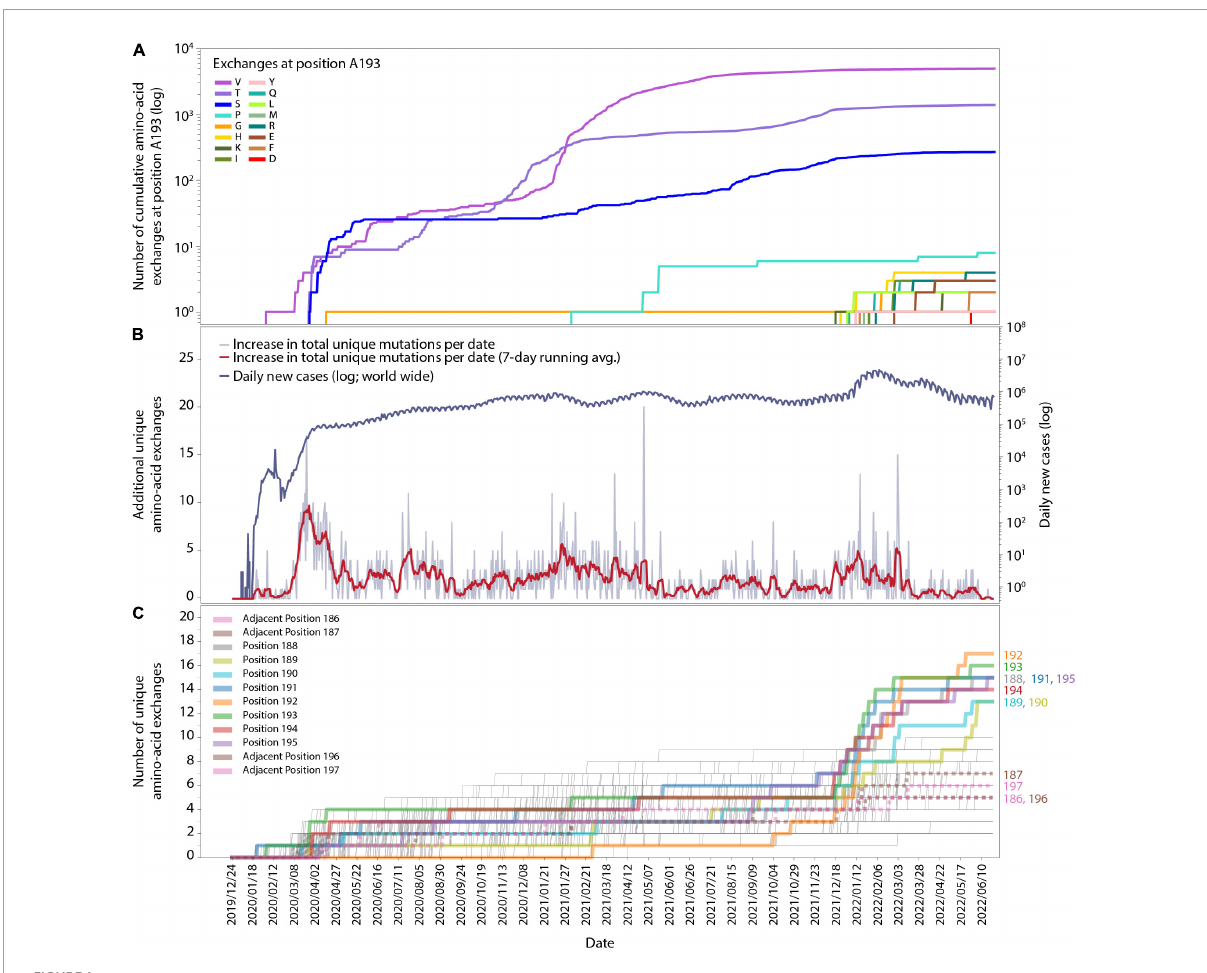
FIGURE1 Time-resolved mutation dynamics of M pro . (A) Logarithmic abundance of single-point amino-acid exchanges at position A193, as a representative for the residues in the region of interest, within the total set of 10.5 million M pro sequences. (B) Logarithmic daily infection numbers (dark blue) reported by WHO (https://covid19.who.int/data, accessed on 30 June 2022) in connection with the increase in total (summed over all positions and possible exchanges) unique amino-acid exchanges (gray), with a 7-day running average in red. (C) Number of unique amino-acid exchanges for all 306 positions in the M pro sequence. Positions R188-G195 (solid) and adjacent residues V186, D187, T196, and D197 (dotted) are highlighted with bold